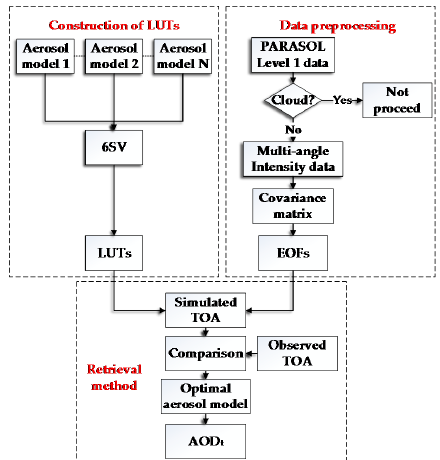
Figure 1. The aerosol optical depth (AOD) retrieval flowchart. LUTs, lookup tables; 6SV, Second Simulation of a Satellite Signal in the Solar Spectrum, Vector version; PARASOL, Polarization and Anisotropy of Reflectances for Atmospheric Science coupled with Observations from a Lidar; EOFs, empirical orthogonal functions; TOA, top of atmosphere.